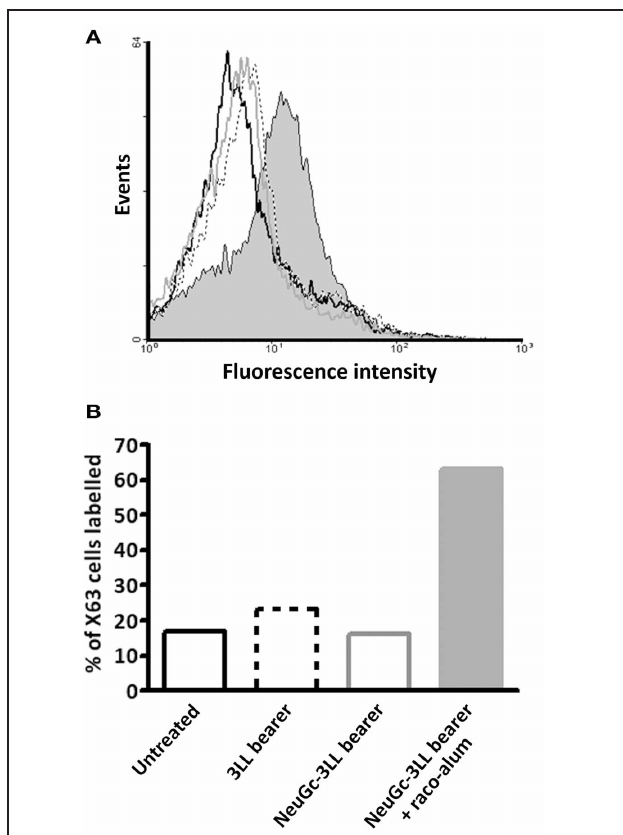
FIGURE 5 | NeuGc-specific humoral response elicited by racotumomab-alum vaccination. Mice were challenged subcutaneously with 3LL cells preincubated or not with purified NeuGc, and immunized with racotumomab-alum (raco-alum) at 50 μ g/dose, as described in “Materials and Methods.” After tumor growth, pooled sera from the different groups were obtained and analyzed by flow cytometry against X63 cells expressing NeuGcGM3 ganglioside. (A) Flow cytometric analysis. (B) Percent of recognized X63 cells. Data from healthy untreated mice (black line), mice bearing control 3LL tumors (dotted line), mice bearing NeuGc-enriched 3LL tumors (gray line), and mice bearing NeuGc-enriched 3LL tumors and immunized with raco-alum (filled